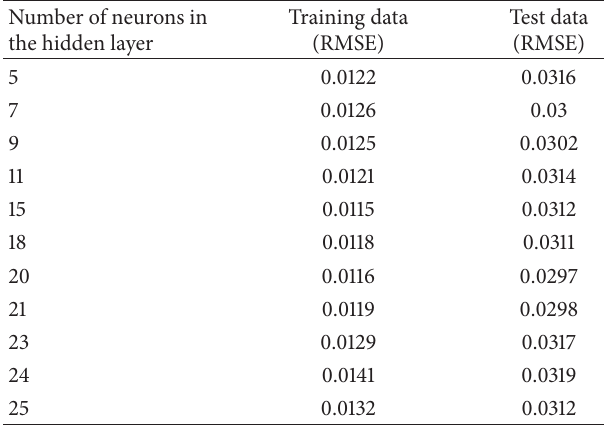
Table 1: Trial and error calculations for selecting the most suitable